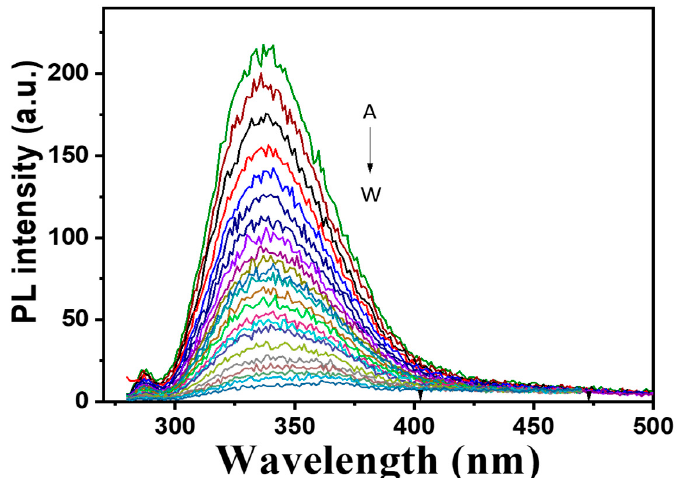
Figure 9. The photoluminescence spectra of Melac13220 laccase from Methylobacterium extorquens in 20 mM Tris-HCl buffer (pH 7.5). The dotted lines show the increasing Fe 2+ concentration from top to bottom (A–W, from 0.01 mM to 0.47 mM).